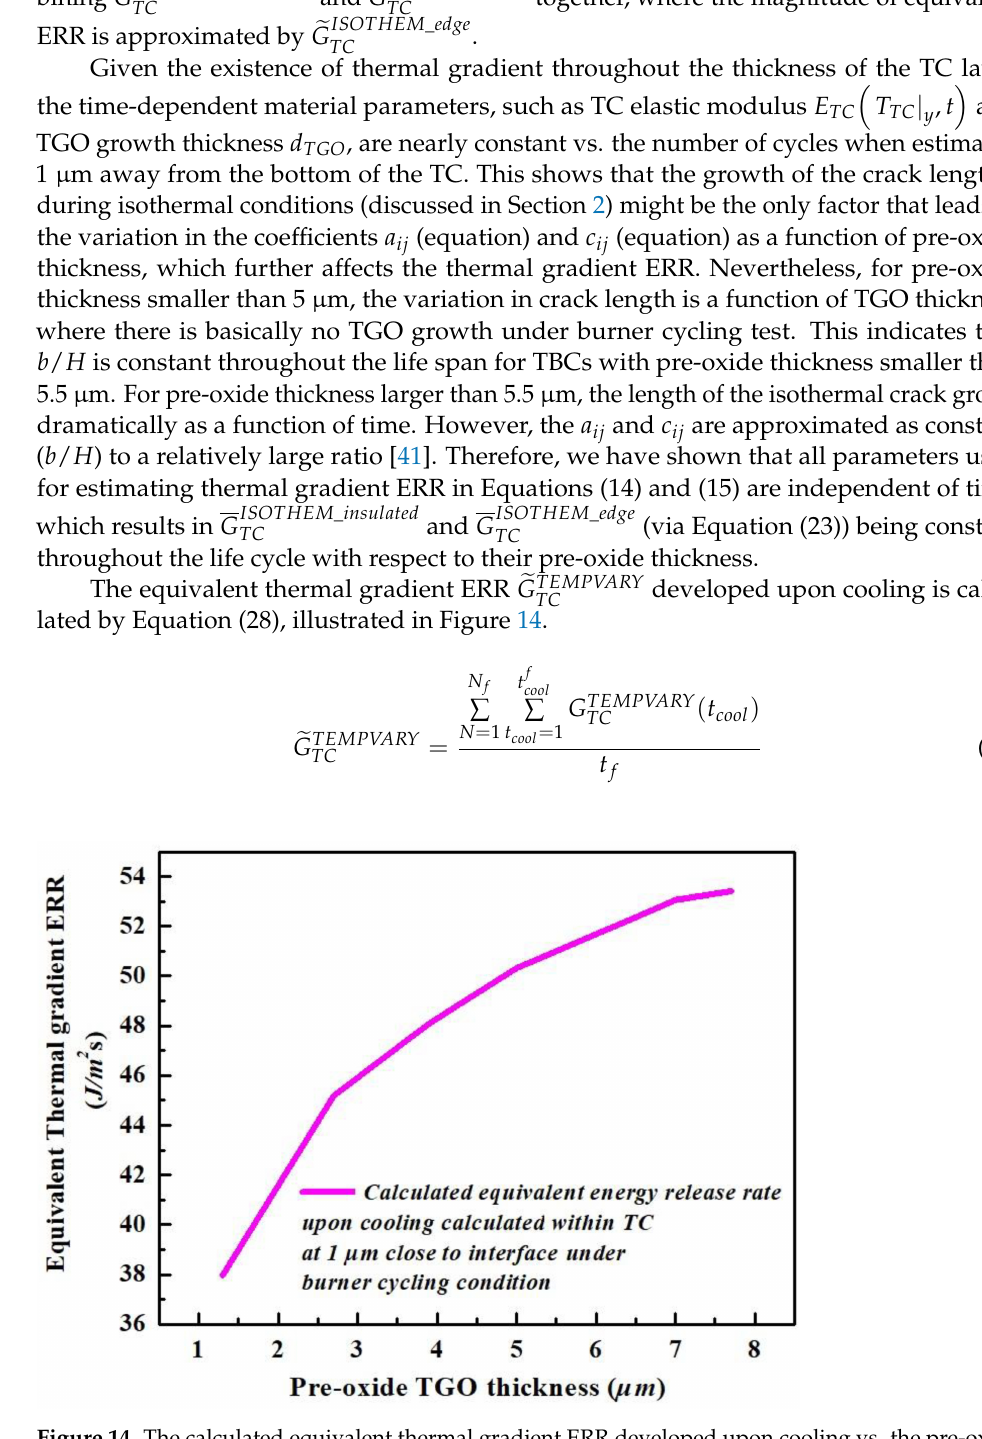
Figure 14. The calculated equivalent thermal gradient ERR developed upon cooling vs. the pre-oxide TGO thickness under burner cycling